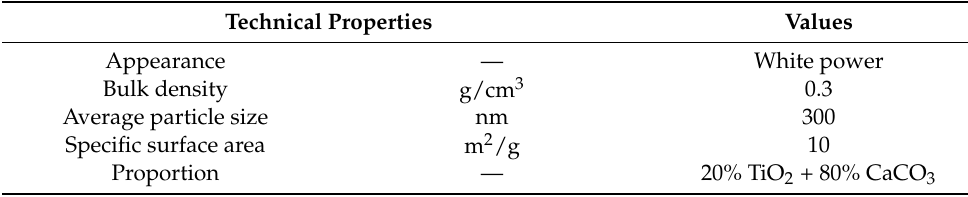
Table 2. Technical properties of nano-TiO 2 /CaCO 3